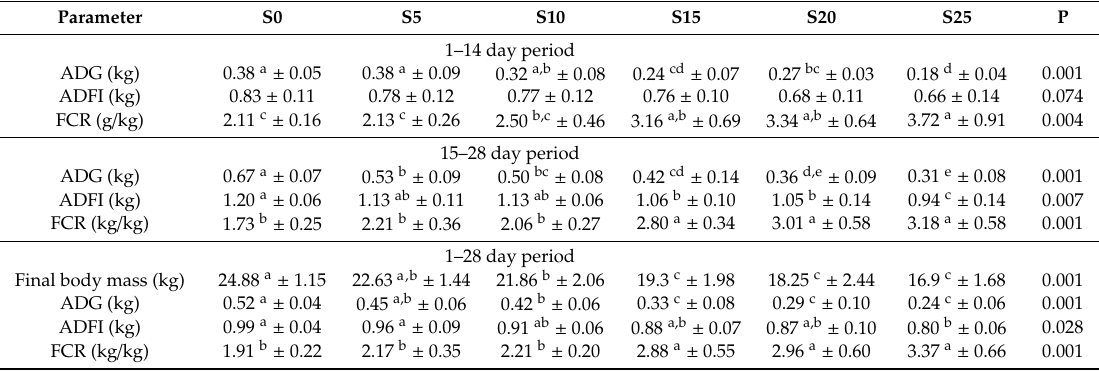
Table 8. Body weight gain, feed intake and feed conversion ratio parameters during the experimental